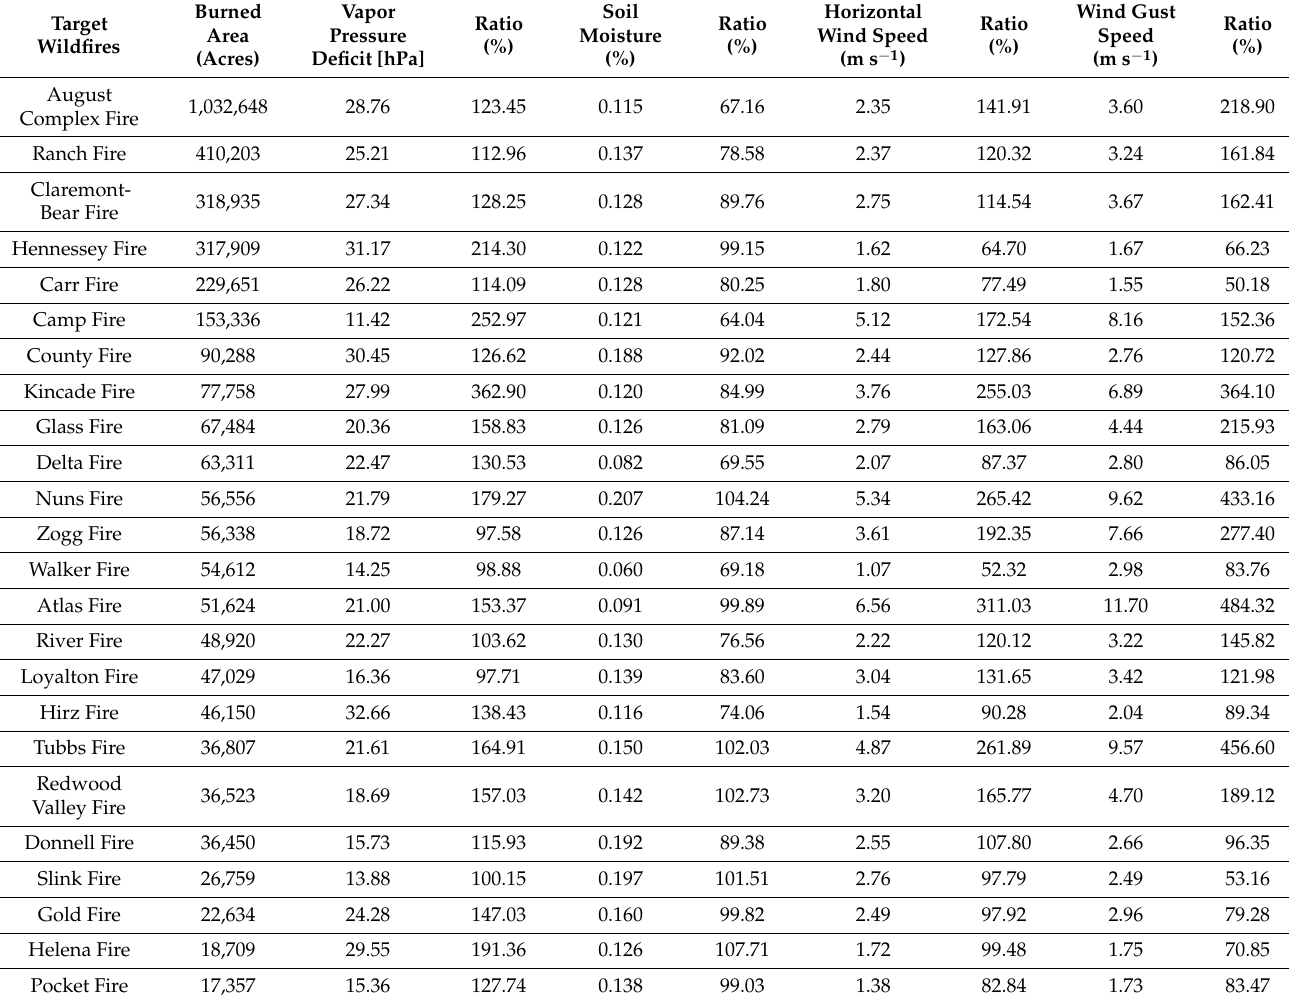
Table 2. Daily averaged hydrological/meteorological variables at the ignition location on the ignition date for each target wildfire. Each variable’s ratio represents the ratio of the daily averaged ignition location variables in the fire-year to the corresponding non-fire-year averaged